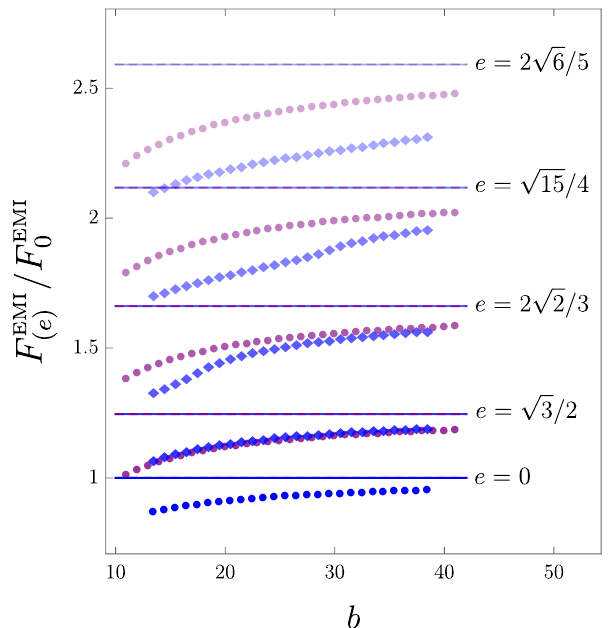
Figure 10 . We plot F EMI /F EMI for different values of the eccentricity e = 0 ( e ) √ √ √ √ 0 , 3 / 2 , 2 2 / 3 , 15 / 4 , 2 6 / 5 using the expressions (A.3) (purple dots) and (A.4) (blue